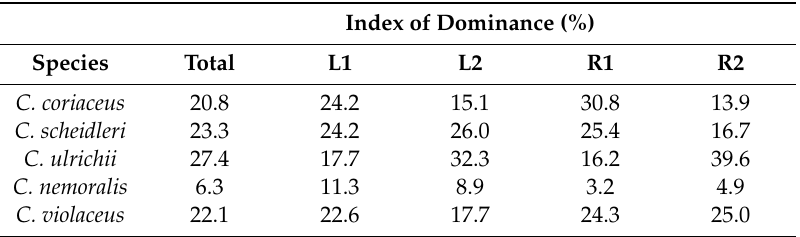
Table 1. The index of dominance calculated for Carabus species at four di ff erent forest stands (L1 and L2 are forest plots and R1 and R2 are recovering forest plots) at the locality of B á b (southwestern Slovakia) in 2017.